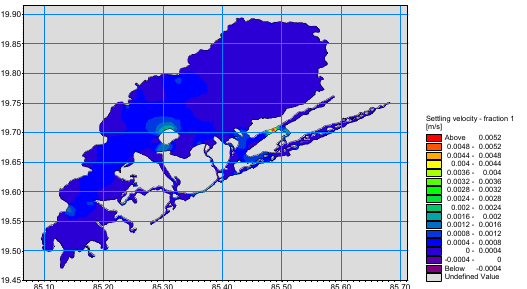
Figure 7e. Simulated spatial profile of Settling velocity -